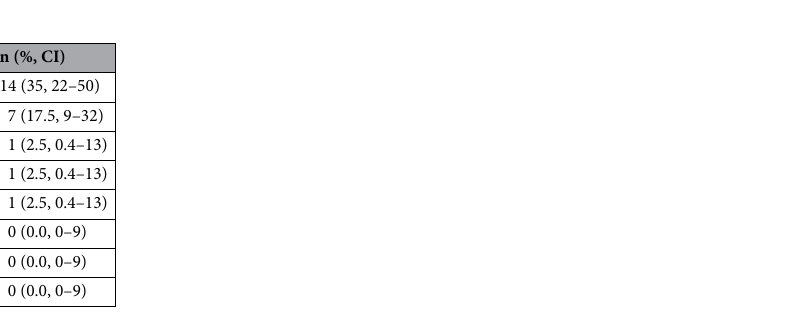
Table 2. Adverse events in the study population. CI 95% confidence interval. All adverse events were Grade